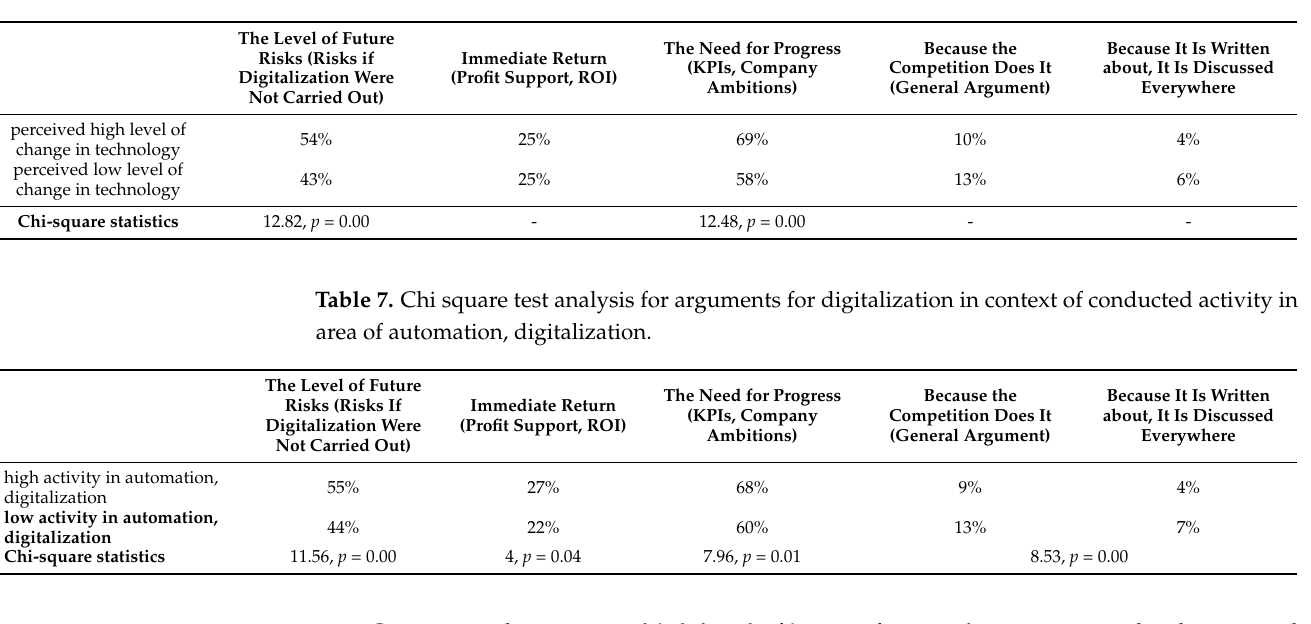
Table 6. Chi square test analysis for arguments for digitalization in context of perceived and expected change in technology.